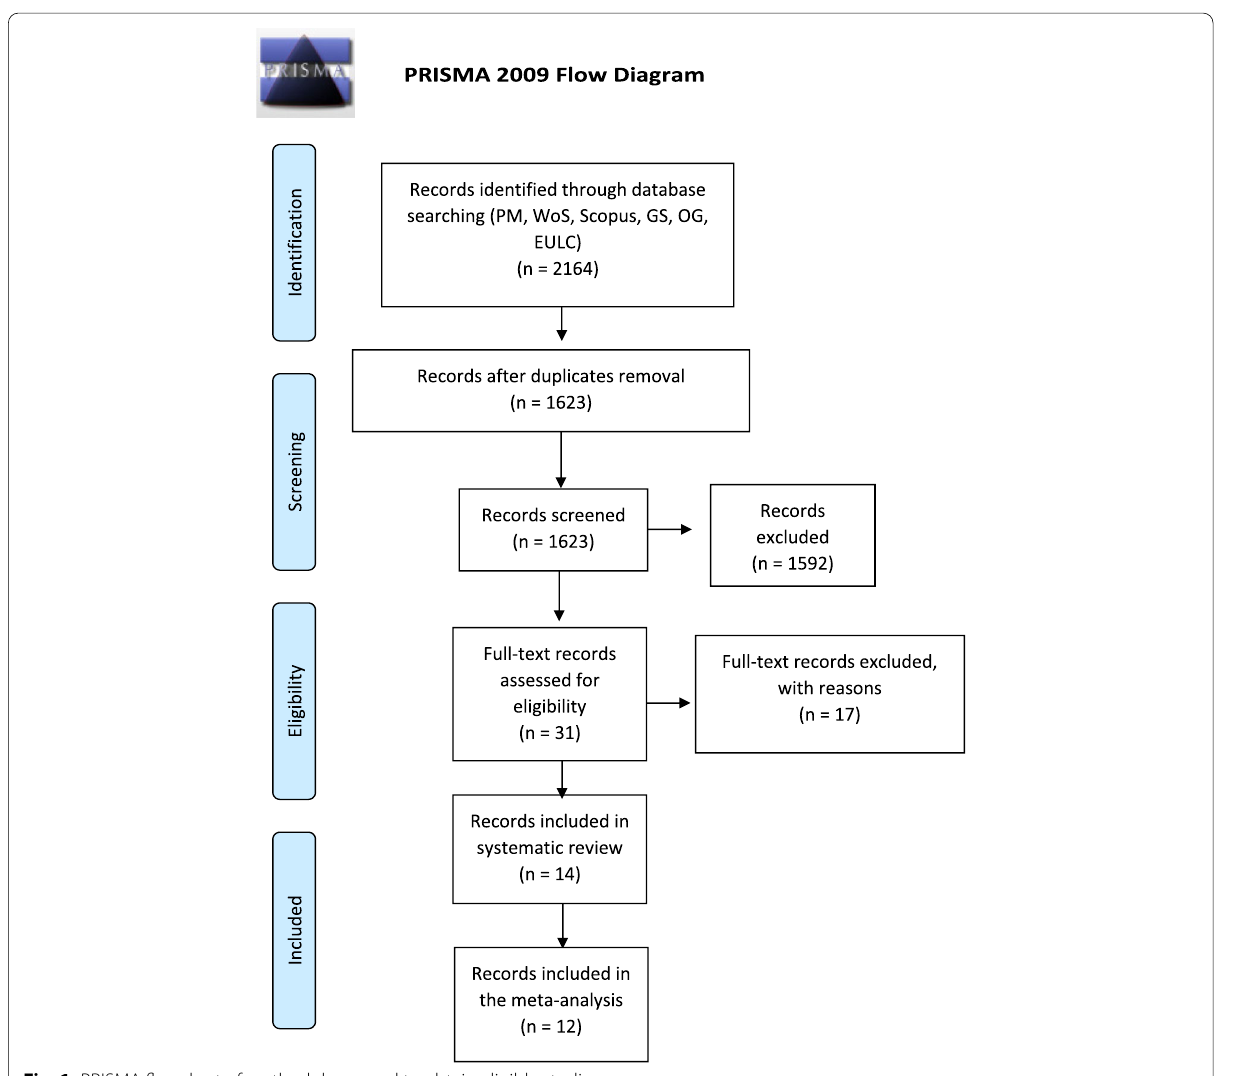
Fig. 1 PRISMA flowchart of methodology used to obtain eligible